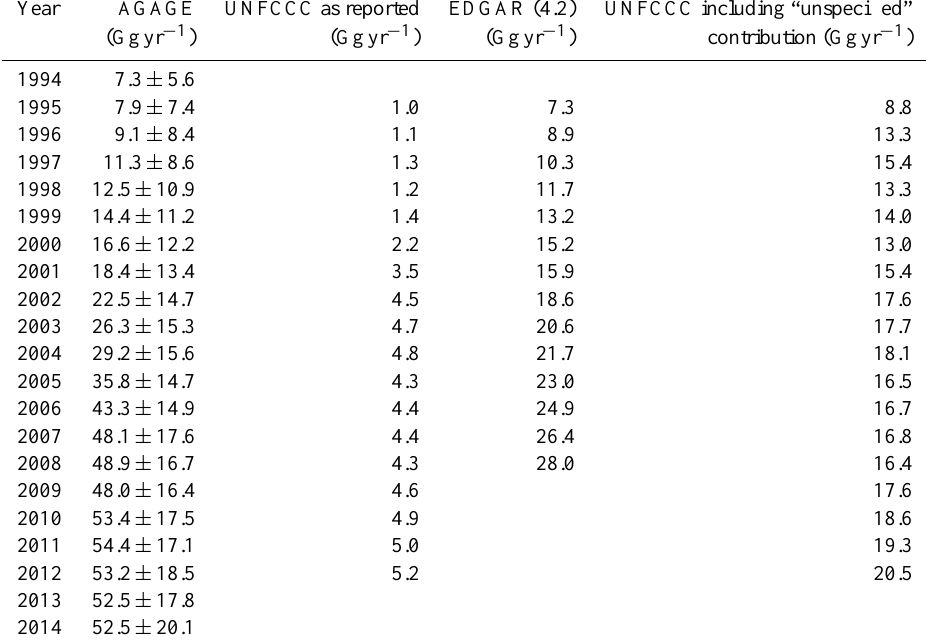
Table 2. Estimates of global emissions of HFC-152a (Ggyr − 1 ± 1 σ) based on AGAGE in situ measurements using the AGAGE 2-D 12- box model. Emission inventories as reported in UNFCCC (United Nations Framework Convention on Climate Change) National Inventory Reports (DoE, 2014; National Inventory Report 2012, submission), EDGAR (v4.2) database and recalculated from the UNFCCC data as described in the